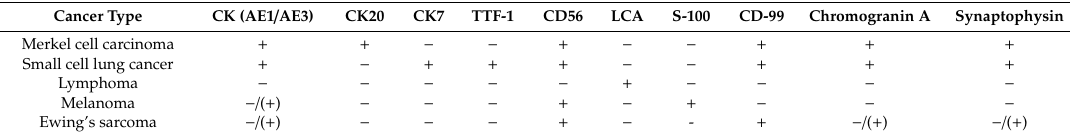
Table 1. Immunohistochemical markers in MCC and common di ff erential diagnosis (Llombart et al. [11]). Cancer